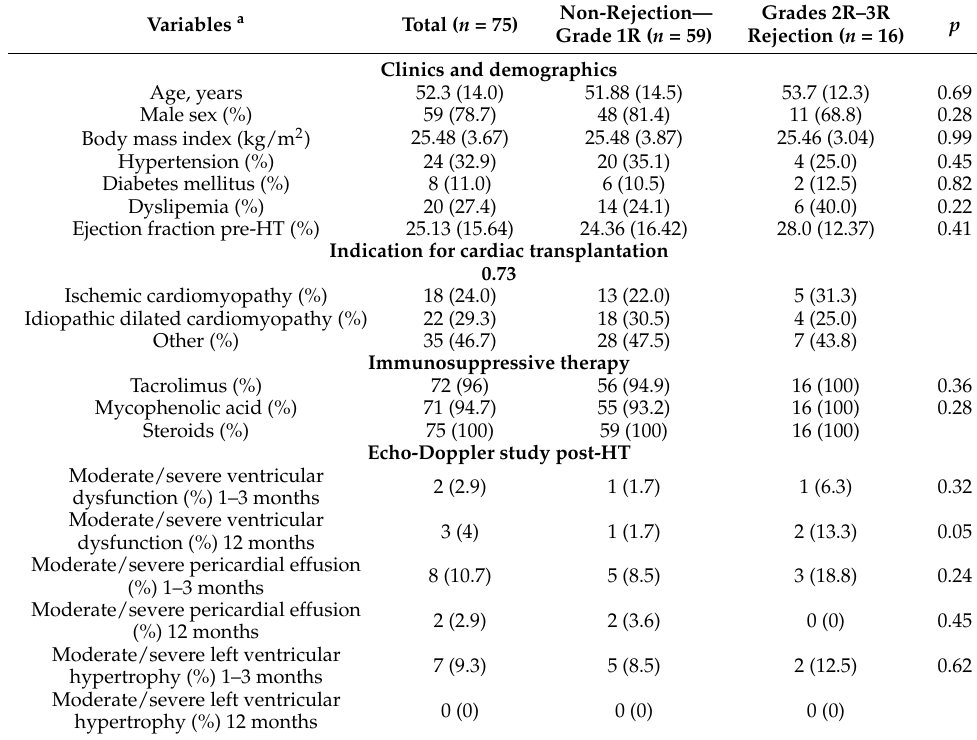
Table 1. Recipient characteristics, immunosuppressive therapy and echo-Doppler